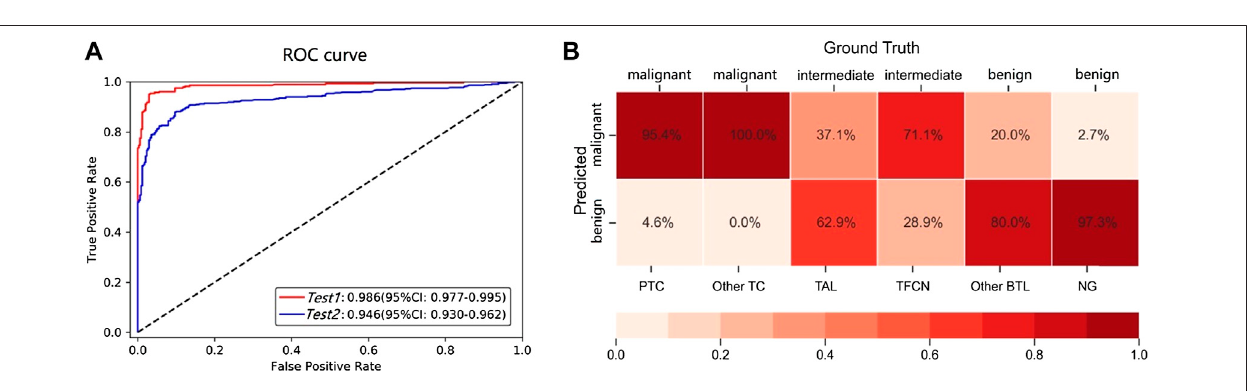
( Figure 1 ). To simulate the real clinical setting in these